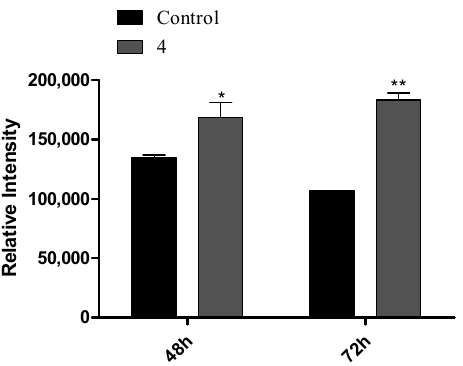
Figure 7. HepaRG relative fluorescence intensity after treatment with compound 4 (50 µM) for 48 and 72 h, obtained by the carboxyfluorescein succinimidyl ester assay. Each bar represents the median with a range of two samples. * p < 0.05; ** p < 0.01 vs. control (two-way ANOVA post-hoc Bonferroni